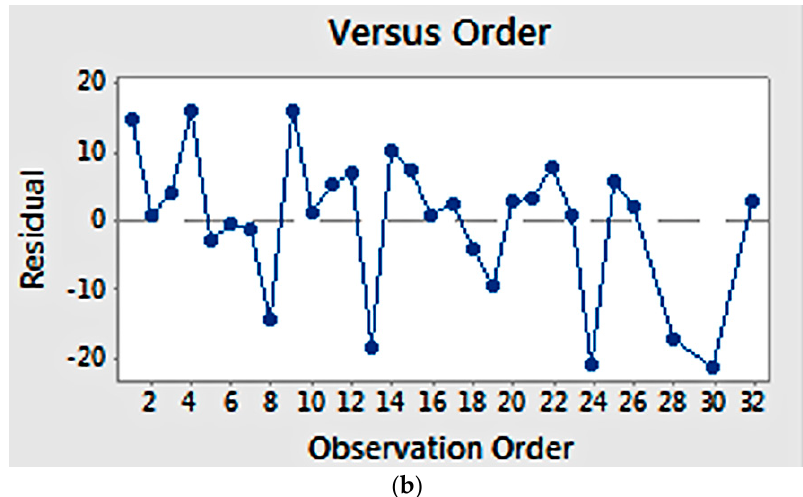
Figure 6. Residual plot for elastic modulus: ( a ) normal probability plot, showing a linear correlation; ( b ) residuals versus order, showing a random correlation.